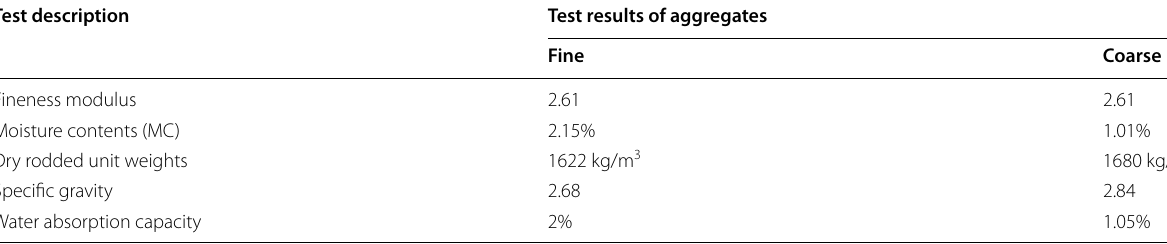
Table 2 Summary of test results for aggregates Test